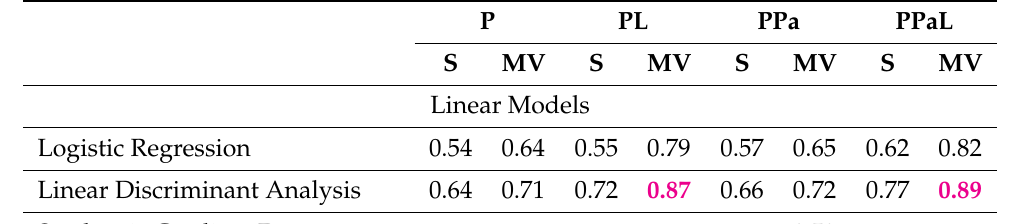
Table 2. Mean of 9 users, Algorithms vs Accuracy of TD-PSD features. 18 gestures wuthout (S) and with majority voting (MV) to stabilize the results.